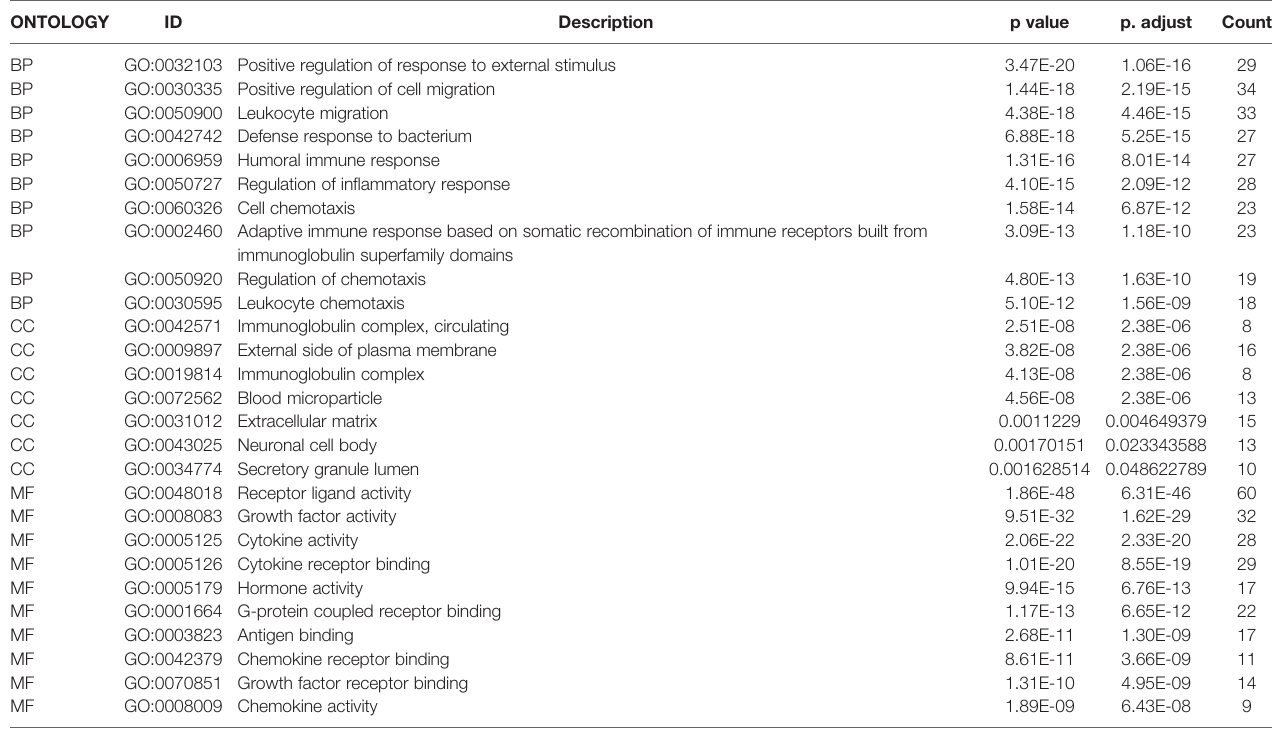
TABLE 1 | GO terms function of IRGs for PCa patients. ONTOLOGY